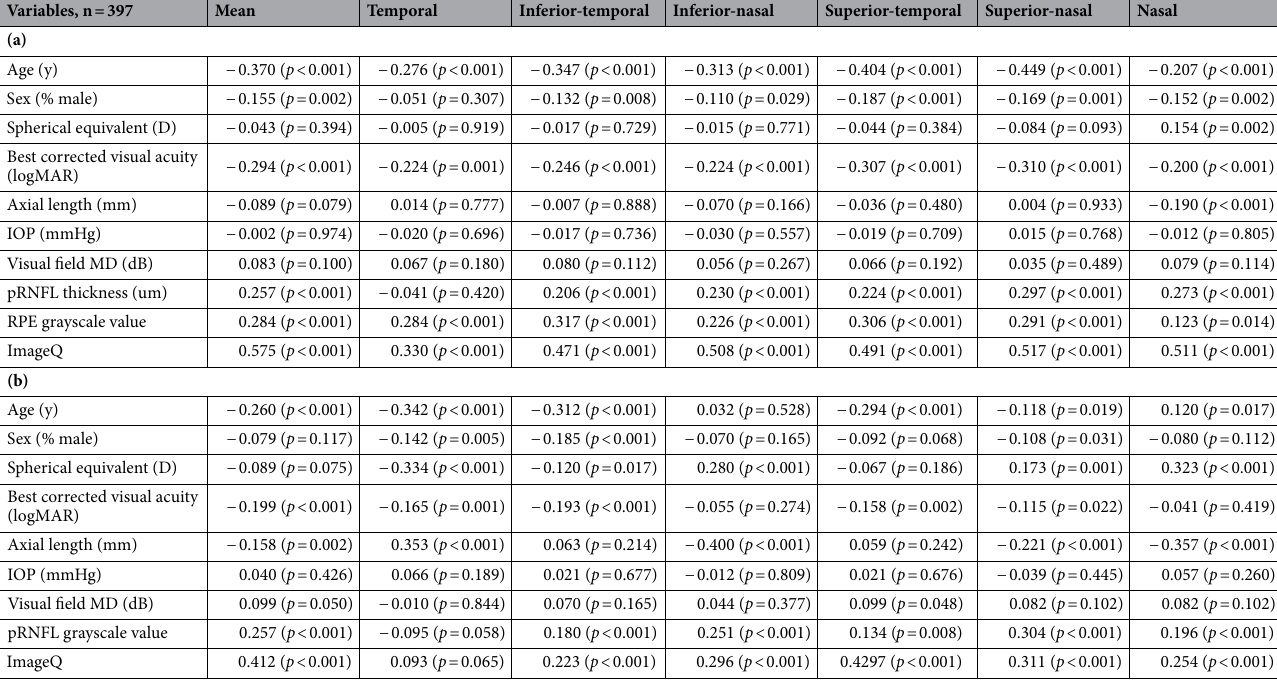
Table 3. Univariable analysis between demographic characteristics and ocular features with pRNFL grayscale value and thickness.